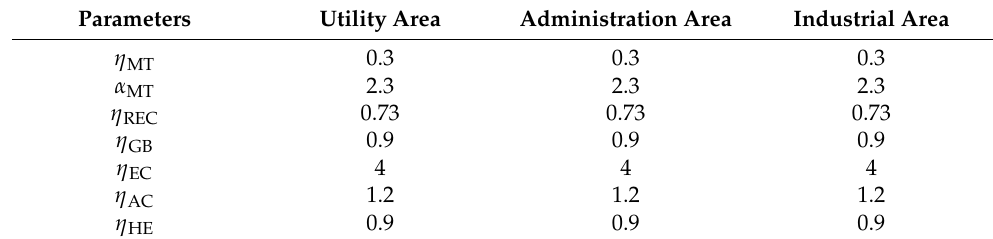
Table 3. Other equipment parameters of RIES.